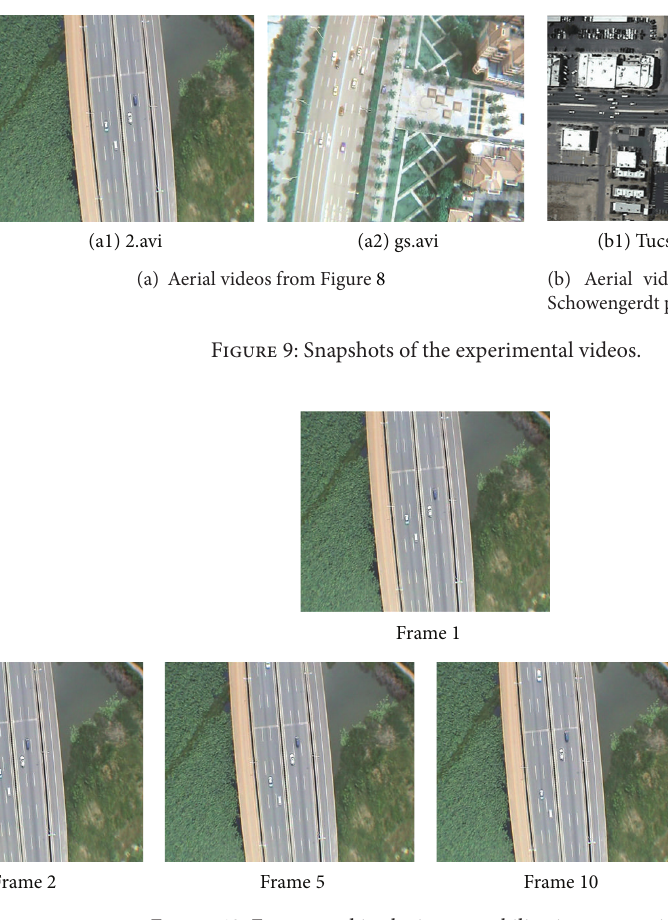
Figure 10: Frame used in the image stabilization